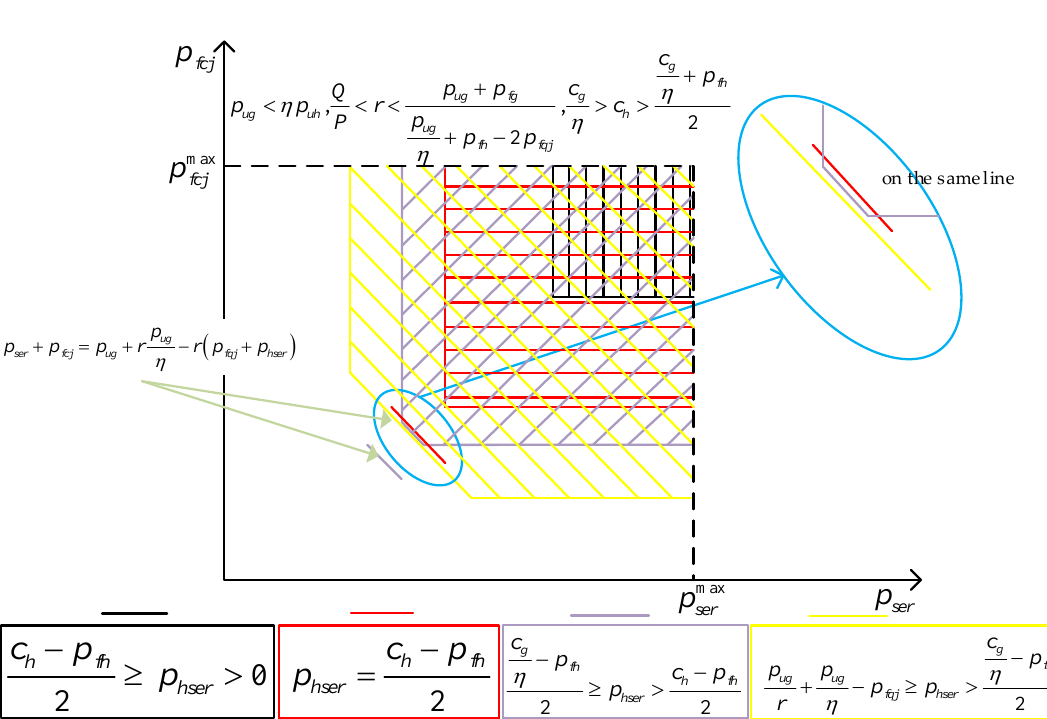
, the Nash equilibria are shown in the purple shaded area of Figure A10.